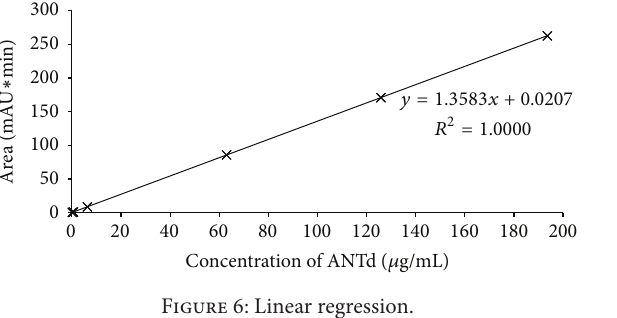
Figure 6: Linear regression.